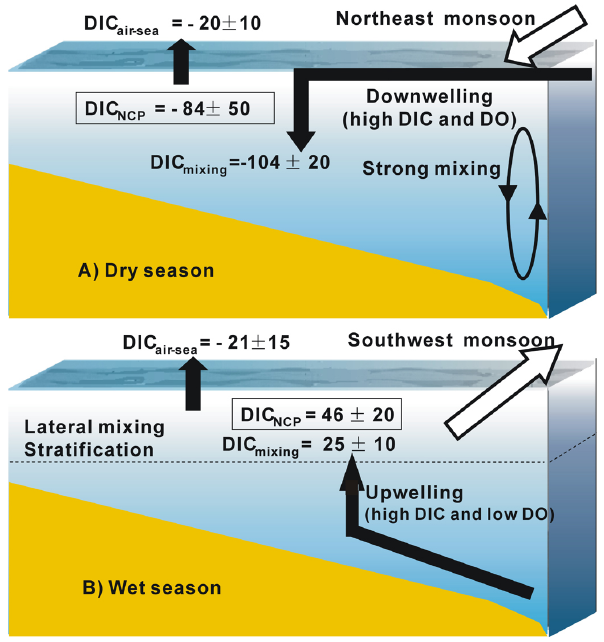
Fig. 6. A conceptual carbon transport model and a mass bal- ance analysis in the (A) dry and (B) wet seasons. Units are in mmolCm − 2 d − 1 . DIC mixing is the mixing contribution to DIC variations; DIC air - sea is air-sea CO 2 exchange; DIC NCP is the in- tegrated net community production in the mixed layer, which were estimated with overall average in the three regions (the Pearl River estuary, Victoria Harbor and EW), respectively. Negative values represent CO 2 losses and positive values are CO 2 releases into water column, but positive NCP corresponds to CO 2 loss. Error bars =± 1SD and n = 14 to